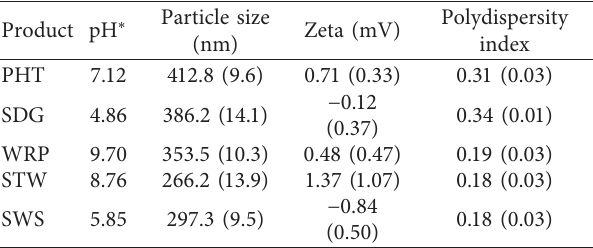
Table 4: Results of the chemical and physical analyses of the toothpaste